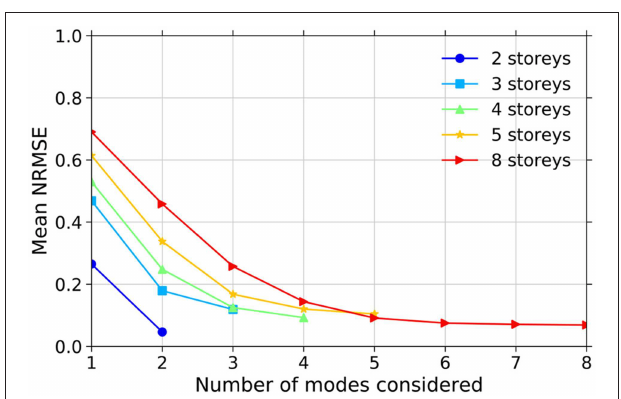
FIGURE 6 | NRMSE of PFA estimation, including different number of vibration